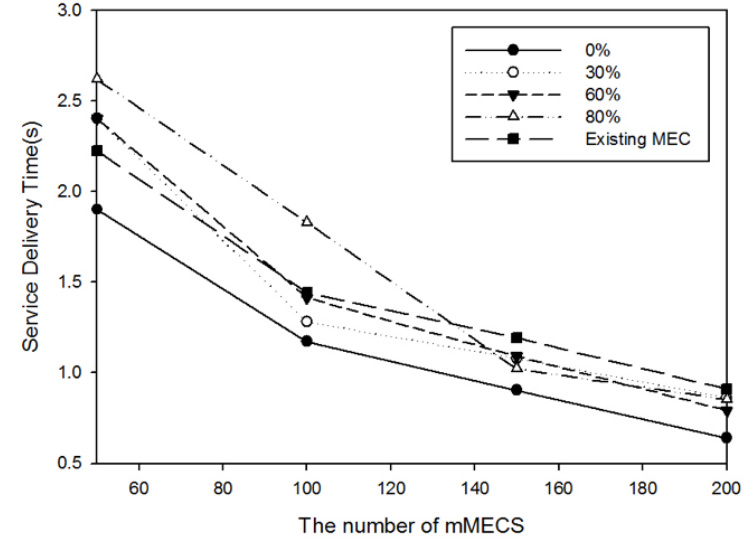
Figure 12. Service delivery time for the mobility preference: Level 1.